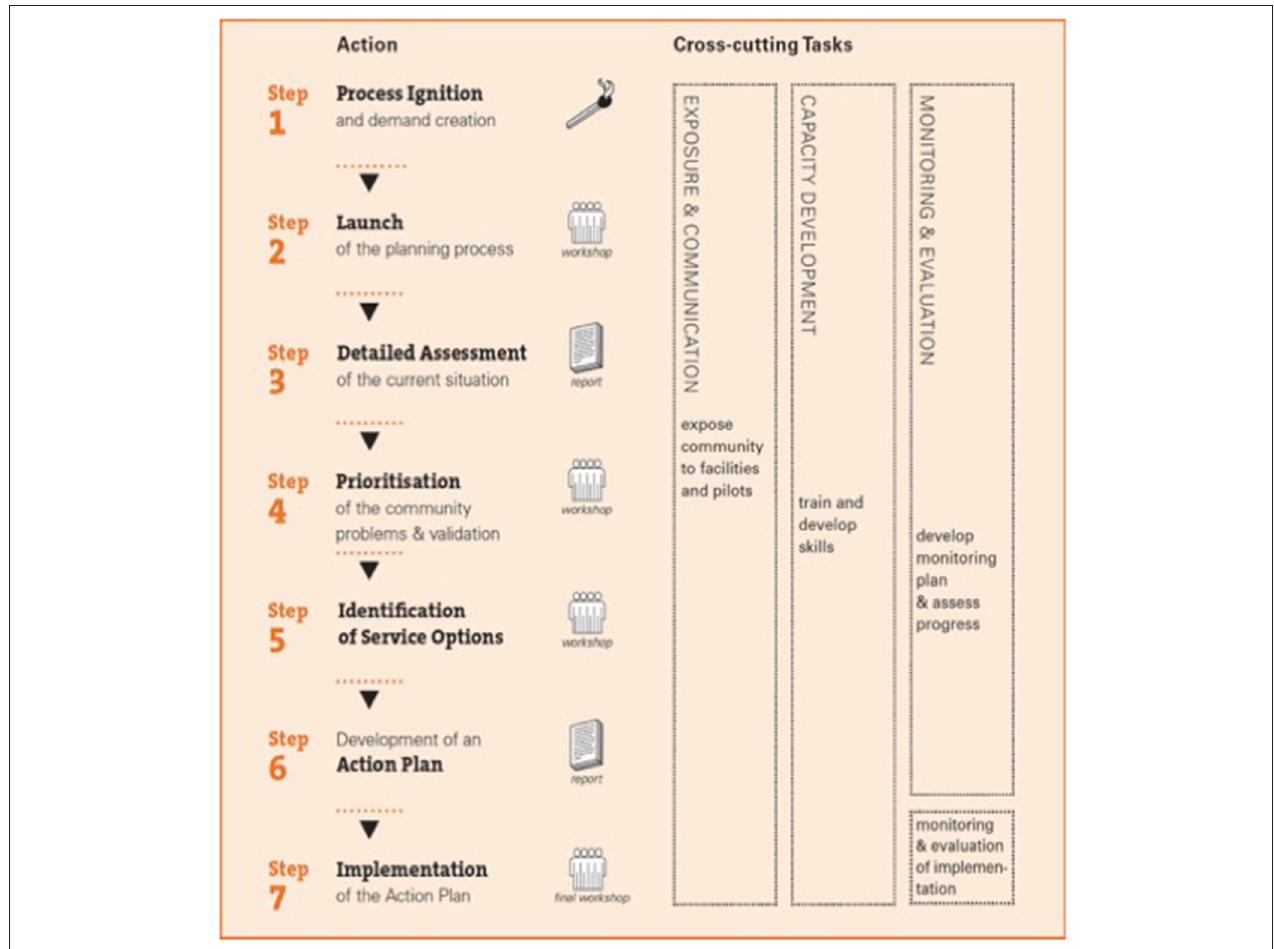
FIGURE 1 | The 7 planning steps of CLUES (Source: Lüthi et al.,